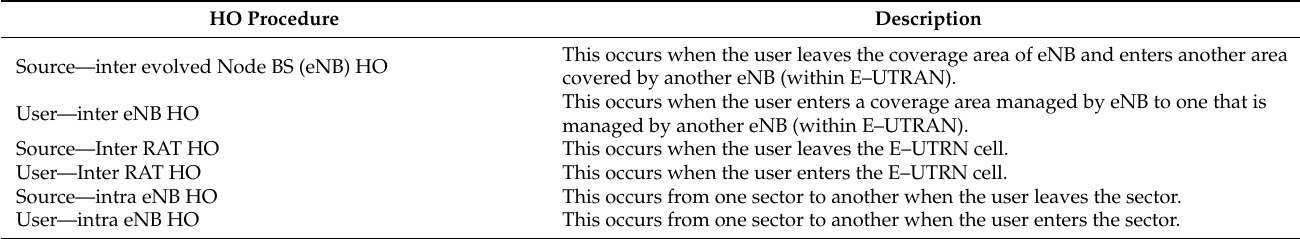
Table 1. HO procedure